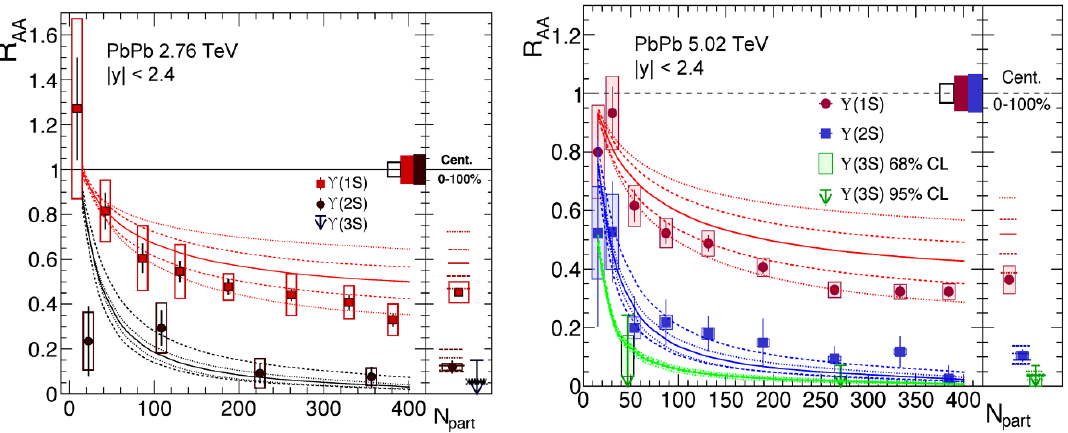
Figure 4 . R (cid:7)( nS ) vs. N part from the CIM with the CMS data at 2.76 TeV [44] and 5.02 TeV [45]. PbPb The uncertainty from the (cid:12)t of (cid:27) co (cid:0) (cid:7) (dashed line) and from the nCTEQ15 shadowing (dotted line) are shown